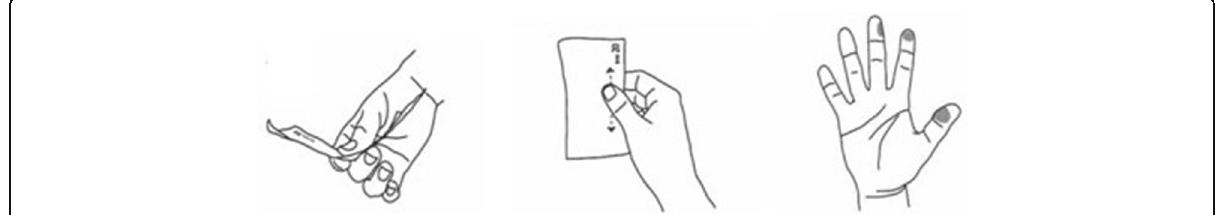
Fig. 2 Haptic banknote interaction. Left: movement over the surface. Bending of the paper, fingers on two sides. Thumb on the front and index finger on reverse. The middle finger is sideways supporting the index finger. Middle: multiple contact areas. Thumb (and not index finger) is used to rub to and fro. It is assumed that typical movement ranges are about 20 mm. Right: various banknote properties are perceived with three fingertips (thumb, index and middle fingers). Illustrations by Wijntjes